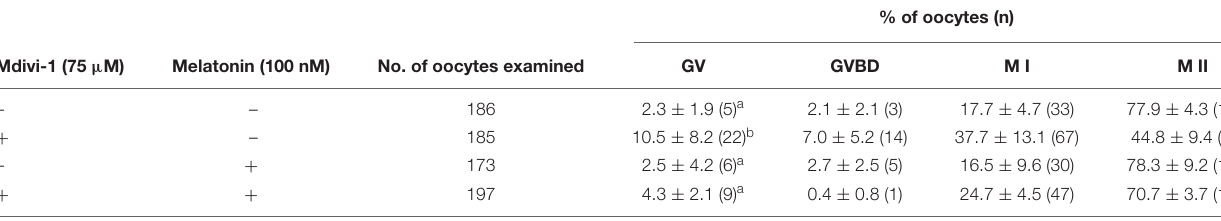
TABLE 3 | Meiotic maturation rate by Mdivi-1 and/or melatonin treatment.